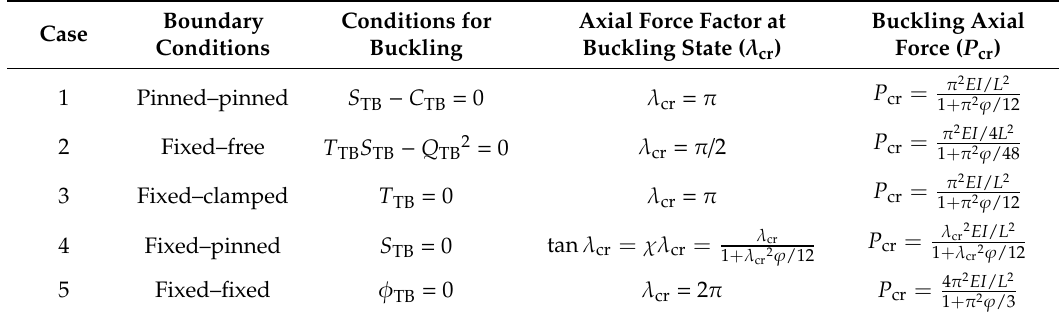
Table 1. Elastic buckling analysis of a Timoshenko column with typical boundary